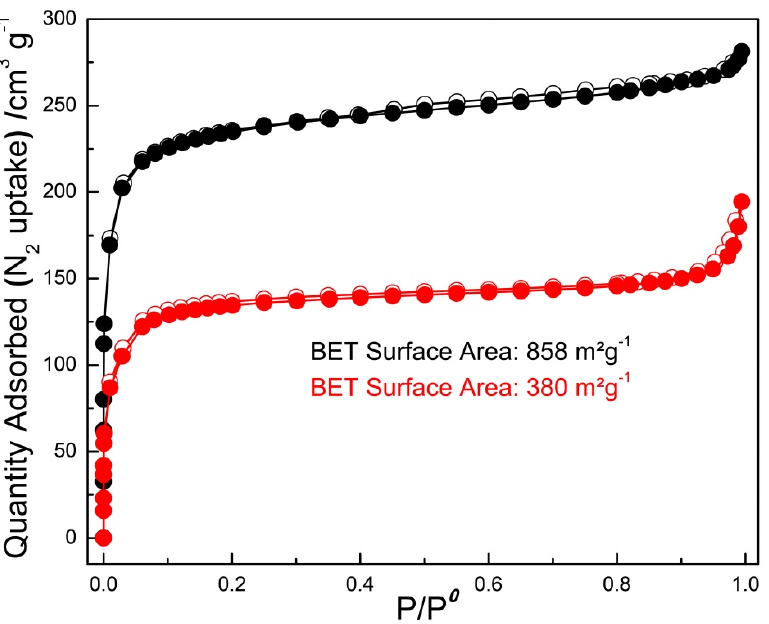
Figure 3. N 2 adsorption isotherm of Ni(MOF) and FH@Ni(MOF). The amount of fluorescein hydrazide appended in the FH@Ni(MOF), as calculated by the alkaline digestion, was found to be approximately 0.211 g g − 1 (0.61 mmole.g − 1 ) of